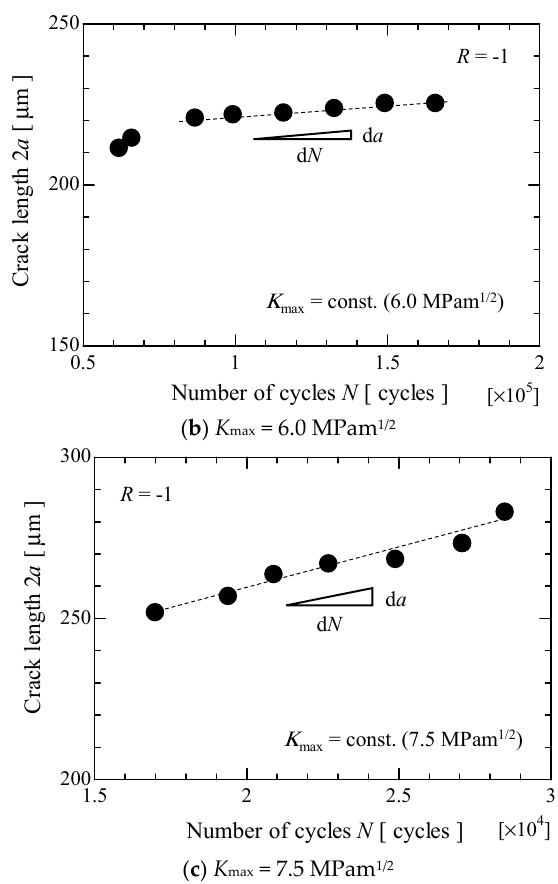
Figure 7. Variation of crack length 2a as a function of number of cycles N under several conditions at R = − 1: ( a ) σ a = 620 MPa; ( b ) K max = 6.0 MPam 1/2 ; ( c ) K max = 7.5 MPam 1/2 .